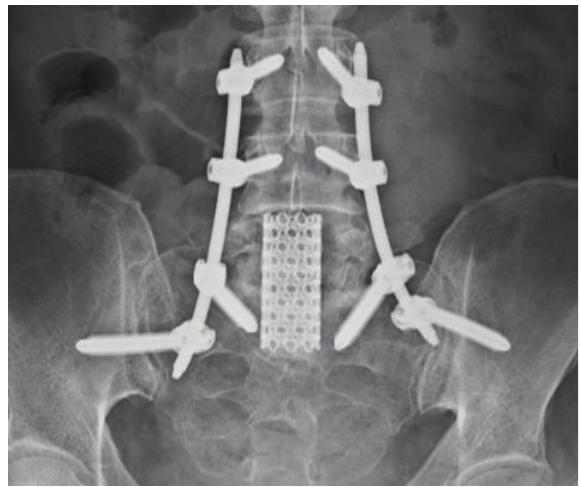
Figure 2: Use of percutaneous posterior instrumentation to stabi- lize open L5 corpectomy.